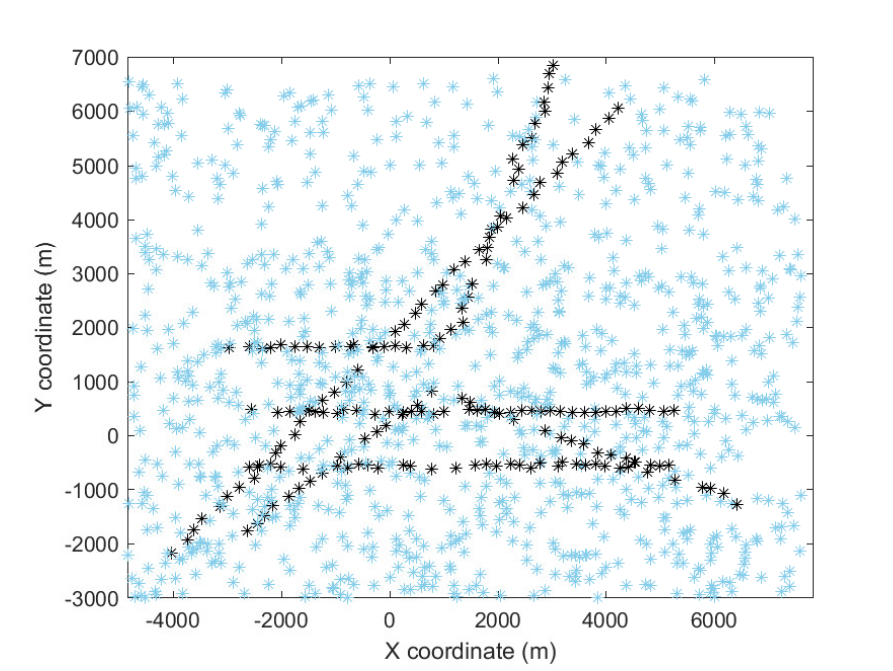
Figure 4. The tracks and measurements with miss detection and